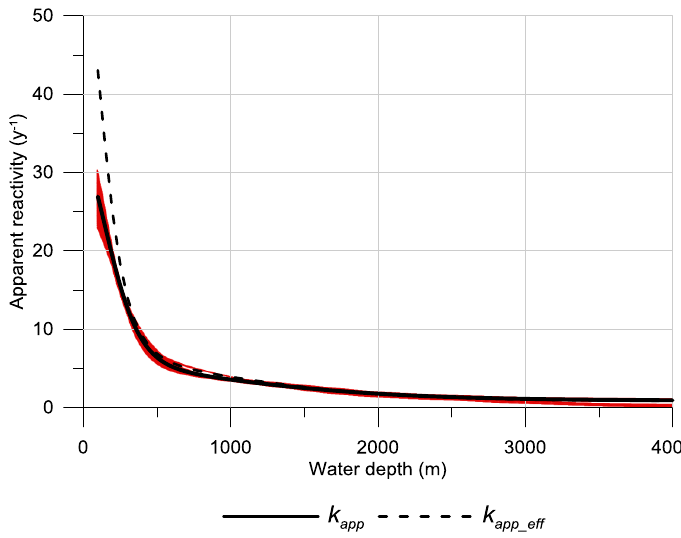
Figure 1. Apparent reactivity of total POC raining to the seafloor (degraded and buried fractions), k app (wd). The cloud of red lines shows k app (wd) from 127 combinations of values for k i,j that resulted in a fit to the Martin curve to within R 2 = 0.98. The solid line shows the power function fit to these combinations (Eq. 8). The dashed curve shows Eq. (14) which corrects k app (wd) for the buried fraction from which k 0 and k 1 are estimated (see